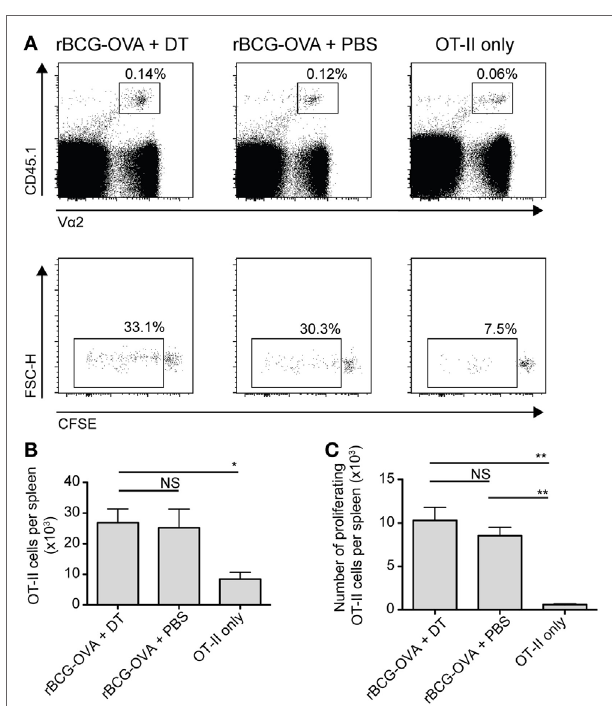
FigUre 3 | OT-II proliferation is unaffected by depletion of langerin + CD8 α + dendritic cells. Lang-diphtheria toxin receptor mice received 5 × 10 6 carboxyflourescein diacetate succinimidyl ester (CFSE)-labeled splenocytes from OT-II × B6 donor mice 1 day before i.v. infection with 10 5 CFU rBCG-OVA. One group of mice was not infected (OT-II only group). Mice infected with rBCG-OVA were treated with 350 ng DT i.p. (or PBS as a control) starting on day − 2, every 2 days until day 6. On day 9 after infection, mice were culled and spleens were removed. The CFSE profile of splenic OT-II cells was assessed by flow cytometry. (a) Representative plots of CD4 + CD45.1 + V α 2 + OT-II cells and their CFSE profiles, gated on proliferating (CFSE intermediate and negative) OT-II cells. (B) The number of OT-II cells and (c) the number of proliferating OT-II cells per spleen are shown ( n = 3 mice per group). NS, not significant, * p < 0.05, ** p < 0.01, one-way ANOVA. The results are representative of two independent experiments.